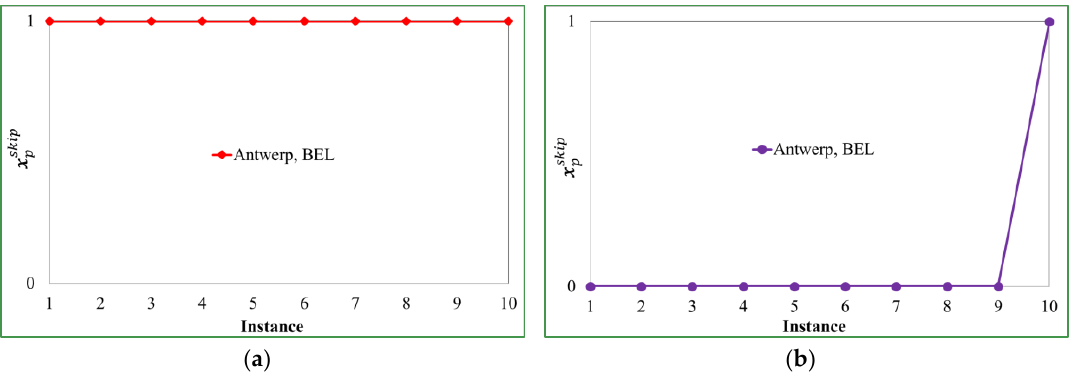
Figure A2. The port skipping decisions for disruption case 2: ( a ) 𝜇 = [1.0] ; and ( b ) 𝜇 = [2.0] .